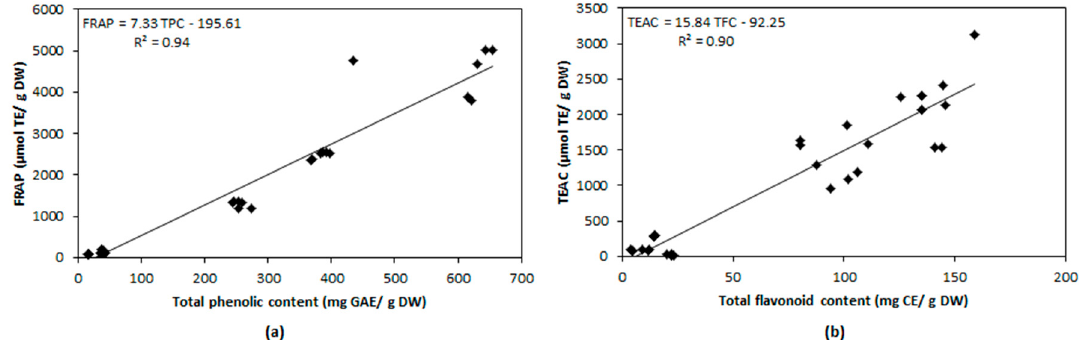
Figure 2. Linear relationship between total phenolic content and FRAP ( a ) and total flavonoid content and TEAC ( b ).